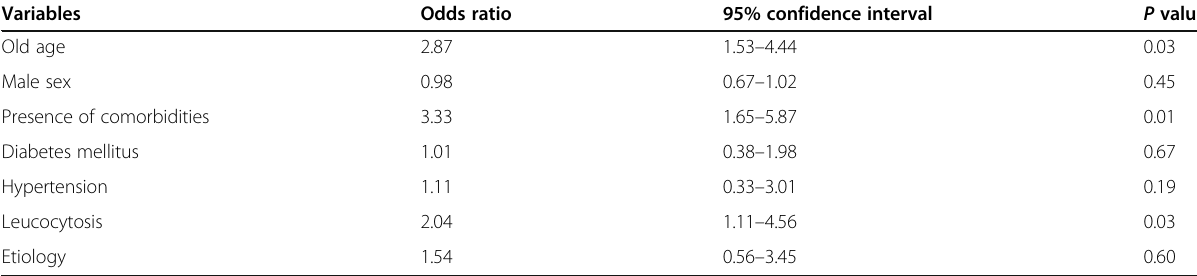
Table 4 Predictors for severe acute pancreatitis in the current study Variables